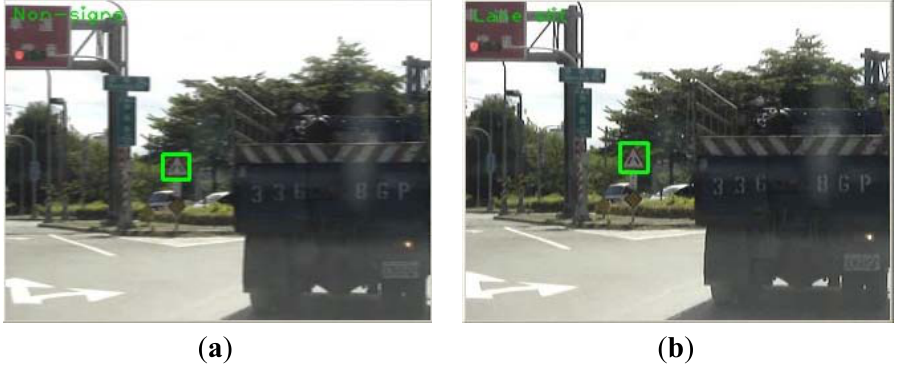
Figure 13. Blurred image may cause error: ( a ) the detection result of the 41st frame of video sequence #08; ( b ) the next frame, which can be recognized correctly.